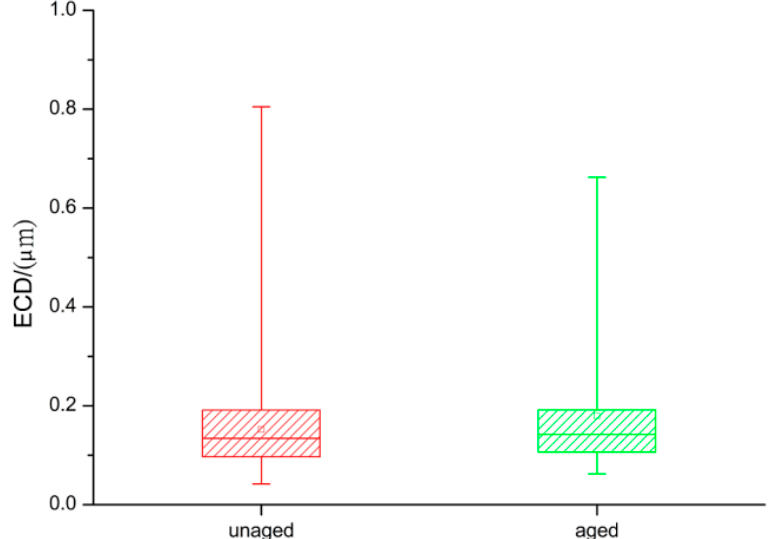
Figure 5. Size of polyethylene wear particles.